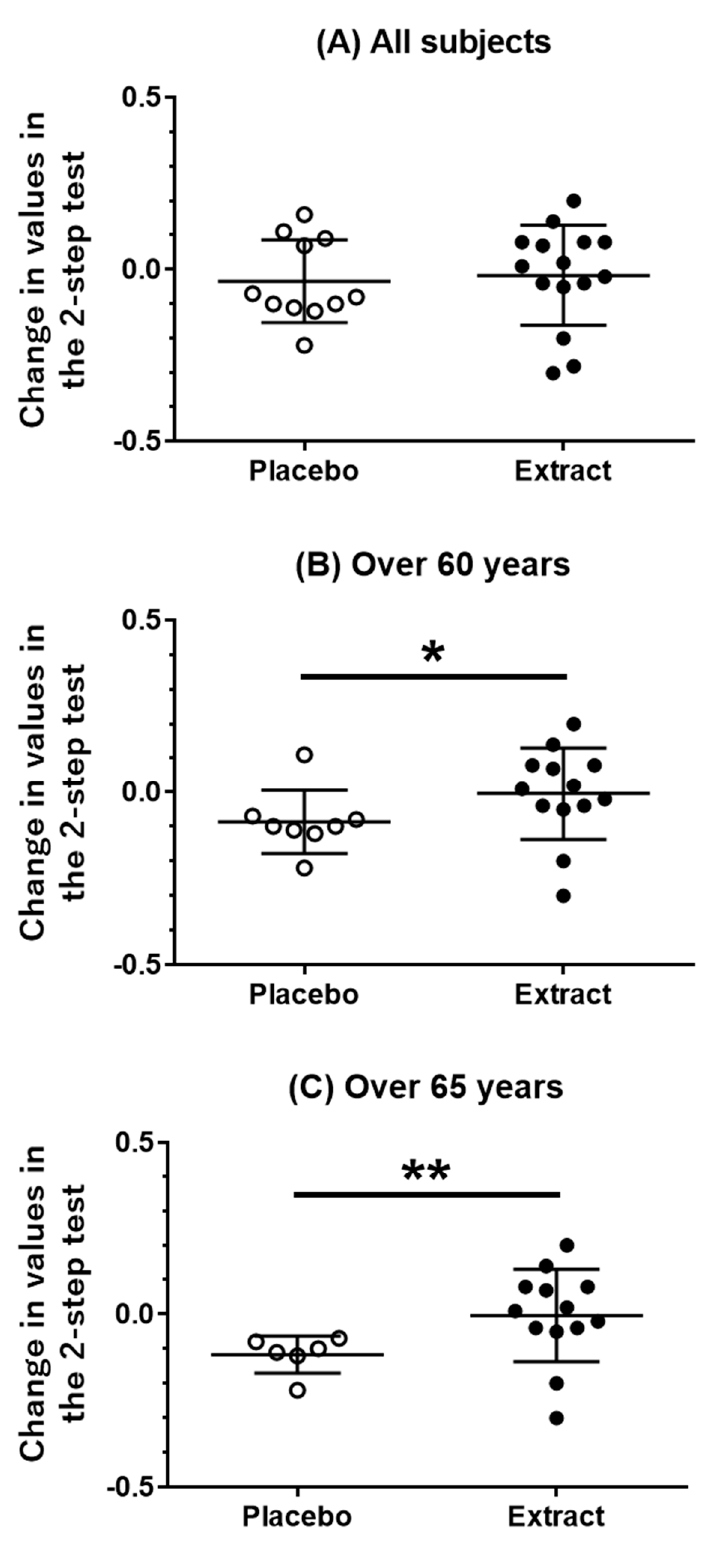
Figure 2. Change in values obtained in the two-step test in the placebo and CT extract groups. Change in values obtained in the two-step test pre-and post-treatment was compared. ( A ) All subjects (placebo; n = 11, CT extract; n = 15), ( B ) subjects aged > 60 years (placebo; n = 8, CT extract; n = 13), and ( C ) subjects aged > 65 years (placebo; n = 6, CT extract; n = 13) were analyzed. * p < 0.05, ** p < 0.01 (Mann Whitney test).